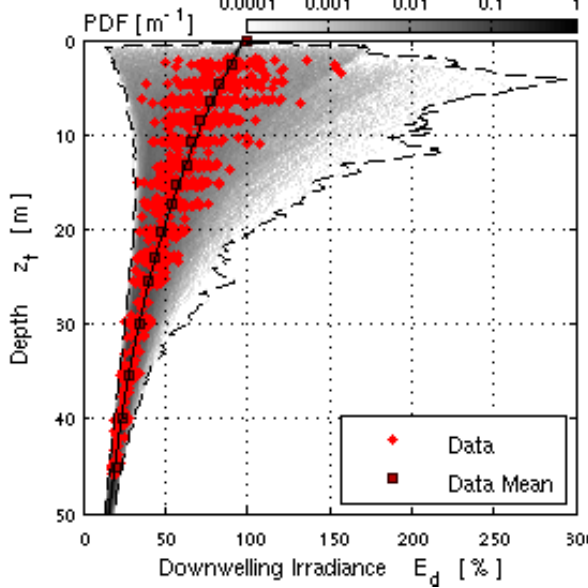
Fig. 2. Comparison of downwelling irradiance E d as calculated by Figure 2. Comparison of downwelling irradiance E the model (for 490nm) vs. offshore measurements with the spectral radiometer at 489nm (30 October 2009); data points in red with 490 nm) vs. offshore measurements with the spectral radiometer at 489 nm (30 Oct. 2009); 4 squares for the corresponding mean values, the modeled PDF with dx = 10cm is gray shaded with dashed data points in red with squares for the corresponding mean values, the modeled PDF with 5 dx = 10 cm is gray shaded with dashed outlines. 6